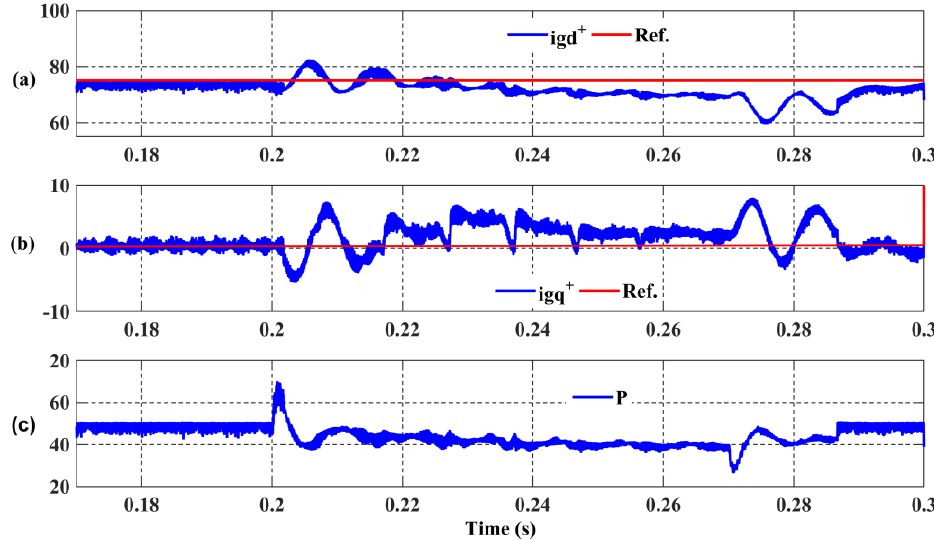
Figure 14. Simulation D results with the conventional PI controller: ( a ) i gd + (A), ( b ) i gq + (A) , and ( c ) P (kW).